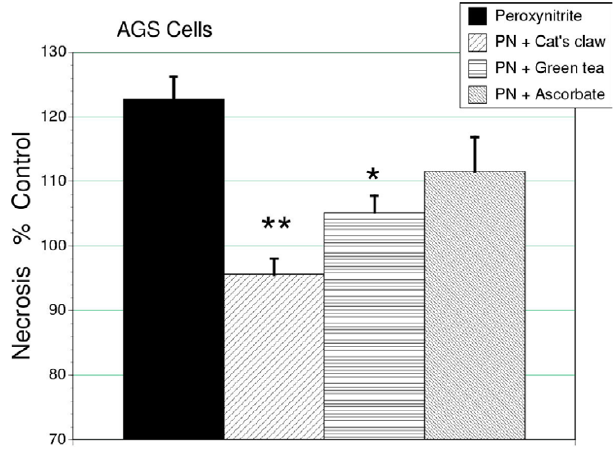
Figure 7 Early stage necrosis in AGS cells treated with peroxynitrite (300 µ M) expressed as a percentage of untreated controls. Both cat's claw ( ** P < 0.01) and green tea extract ( * P0.05) tion in cell